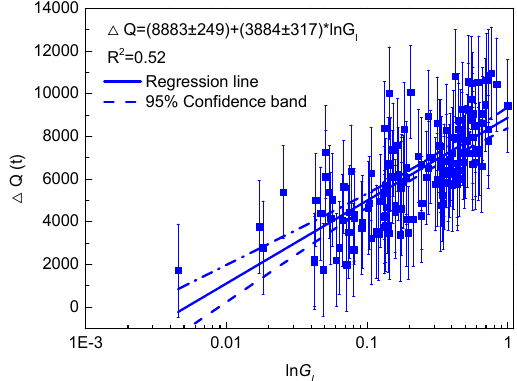
Figure 4. Production increase versus Geological composite index.